Question: What style of plot is this figure drawn as?
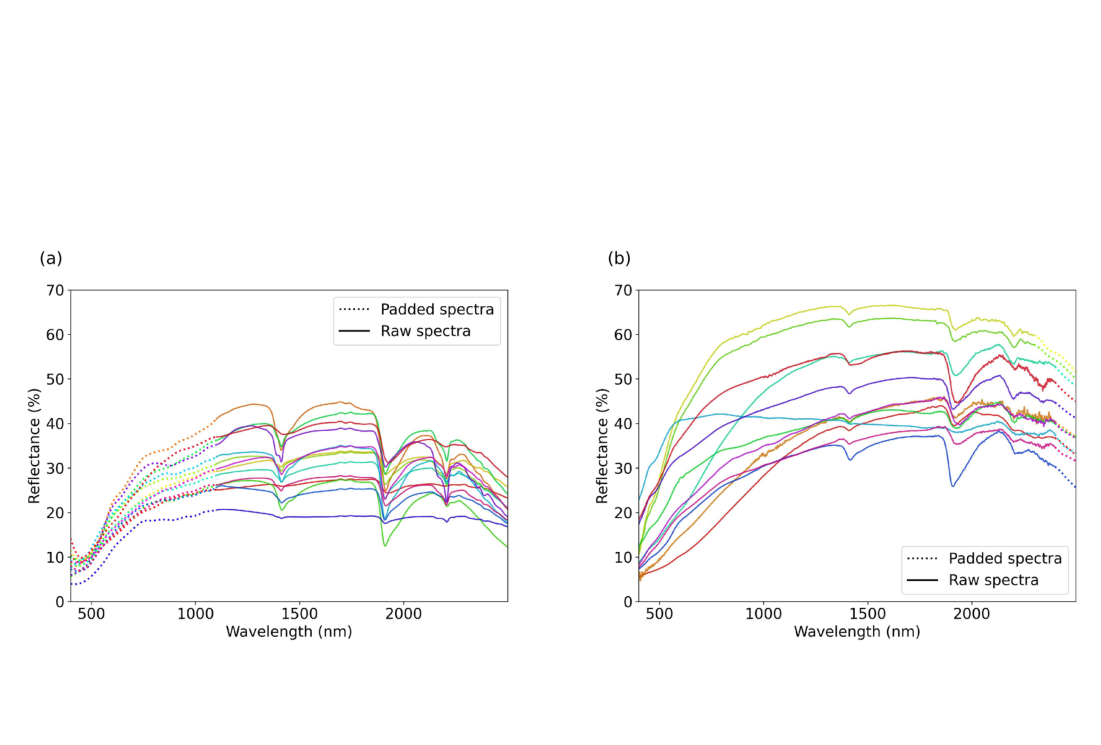
Answer: line